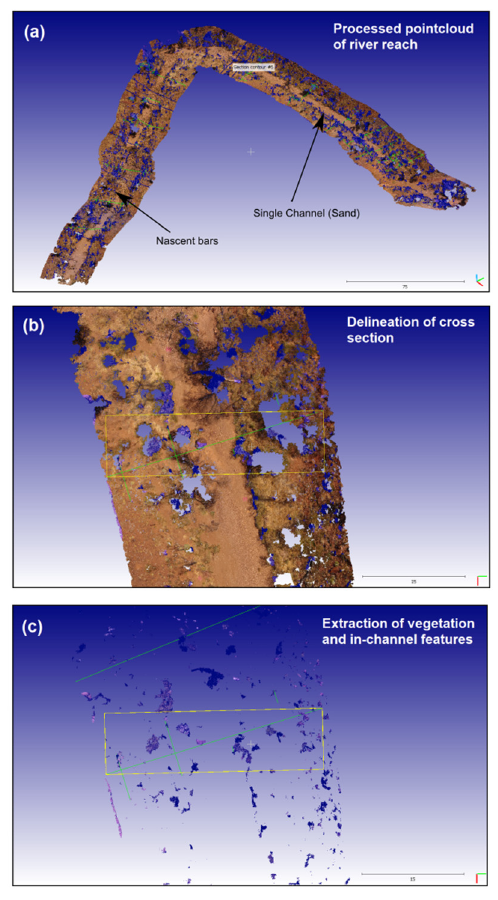
Figure 7. Illustration showing the point cloud processing steps for the estimation of the contribution of vegetation to channel roughness (using an equation from Petryk and Bosmajian, 1975). ( a ) shows a processed poincloud of the river reach with geomorphic features identified, ( b ) highlights the delineation of cross section and ( c ) shows the extraction of vegetation along the cross section.